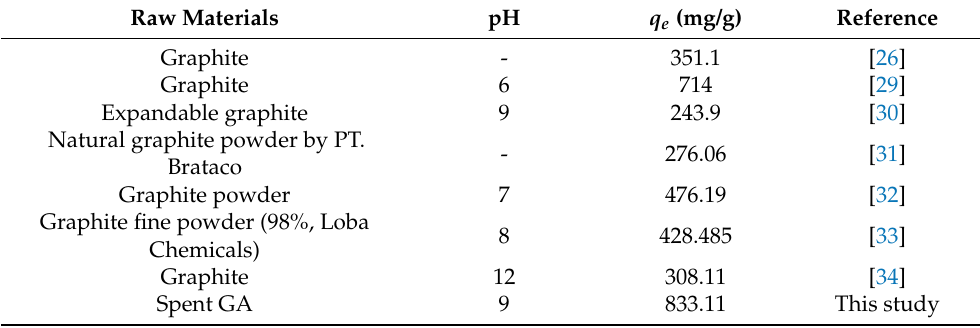
Table 1. The adsorption of MB using GO prepared by Hummers